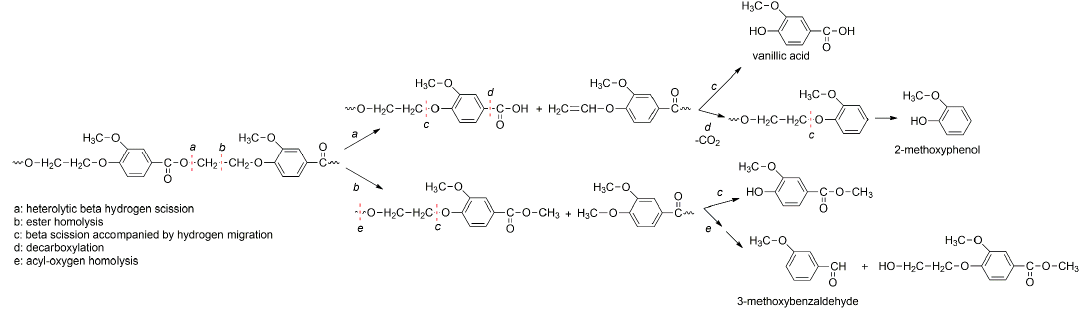
Figure A1. Possible degradation pathways of PEV. Polymers 2019 , 11 , x FOR PEER REVIEW